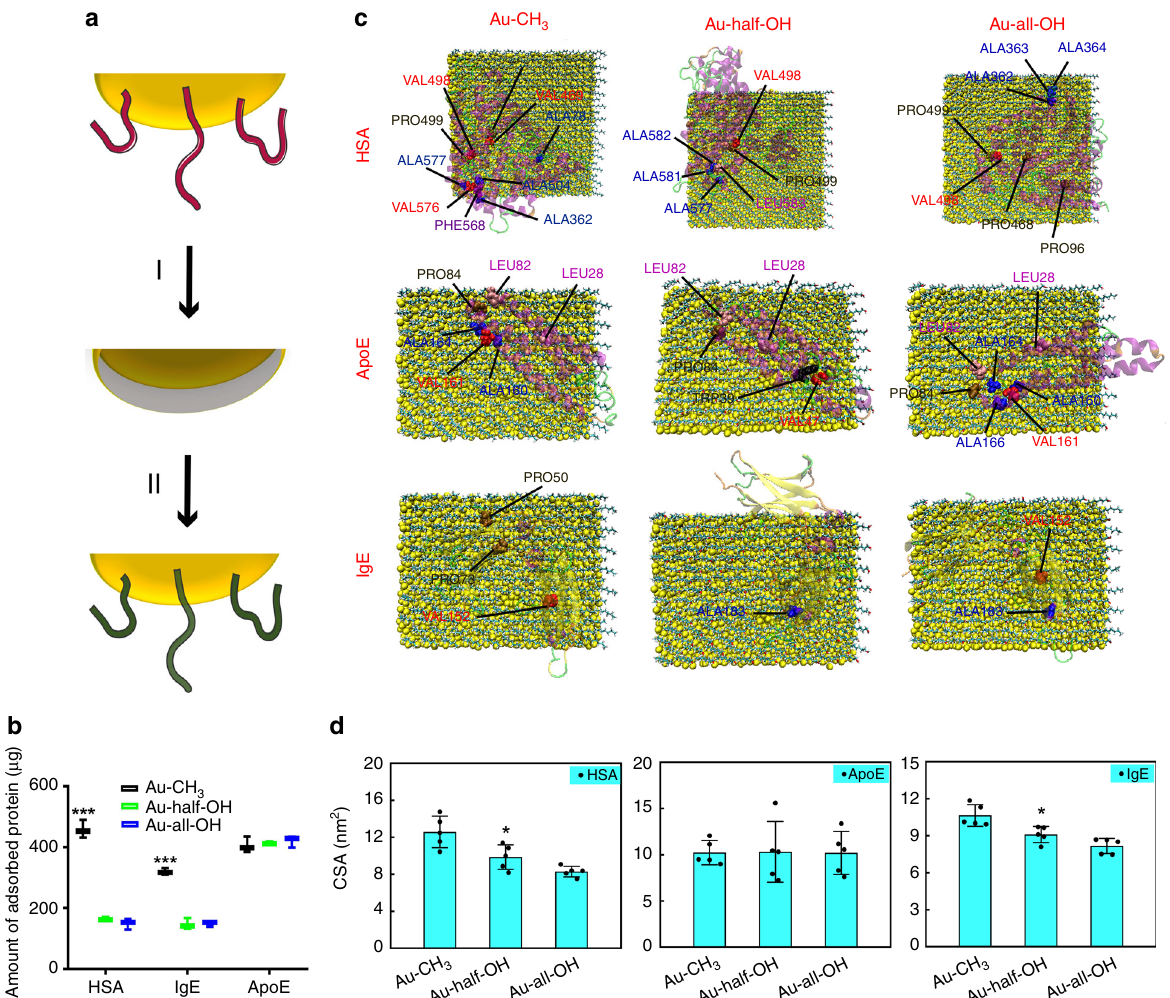
Fig. 6 Pro fi les of protein adsorbed on Au nanoparticles. a Schematic illustrating the step-wise introduction of foreign ligands with the assistance of Ag. I: Deposition of a thin layer of Ag; II: Removal of Ag alongside with the passivation with ligands. b In vitro analyses showing the number of proteins adsorbed on the graphene. Data are presented as mean ± s.e.m. ( n = 3). p Values were calculated using multiple t tests (*** p < 0.001). c Typical fi nal snapshots of the adsorption of three types of proteins onto the Au nanoparticle (yellow) with different surface modi fi cations. The hydrophobic residues within 0.5 nm distance from the surface are represented as CPK spheres. Water molecules and ions are omitted for clarity. d The CSA pro fi les of proteins adsorbed on different Au nanospheres. Data are presented as mean ± s.e.m. ( n = 5). p Values were calculated using multiple t tests (* p < 0.05). For a full spectrum of snapshots and interaction energy pro fi les, please refer to Supplementary Figs. 3 –